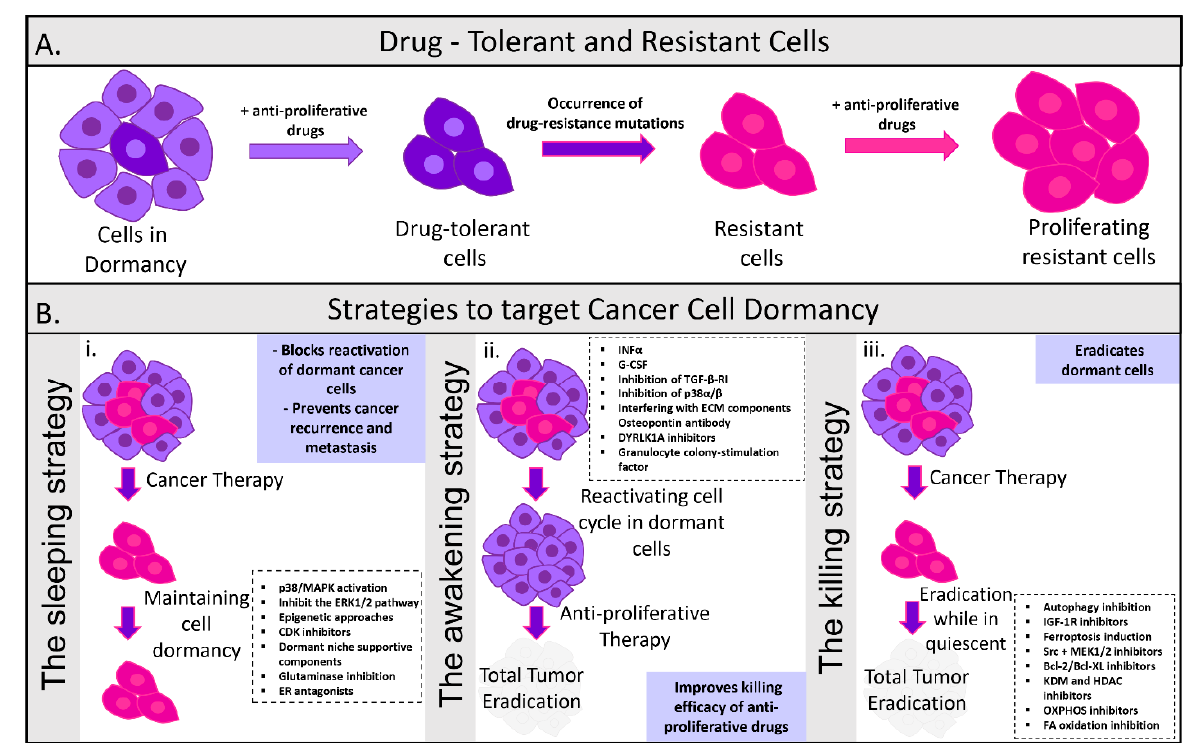
Figure 3. Strategies to target cancer cell dormancy. ( A ) Dormancy is identified as a key feature of cells surviving their first exposure to anti-proliferative cancer drugs. Drug tolerant cells are able to escape the highly selective pressure of anti-proliferative agents and become resistant. Although drug tolerance is a transient non mutational phenotype, rare drug-resistant mutations occur. Drug tolerant persisted cells resume normal growth even in the presence of a drug and form colonies. These drug-resistant cancer cell colonies can proliferate even in the presence of anti-proliferative drugs. ( B ) Overview of the current pharmacological strategies that aim to ( i ) maintain cancer cells